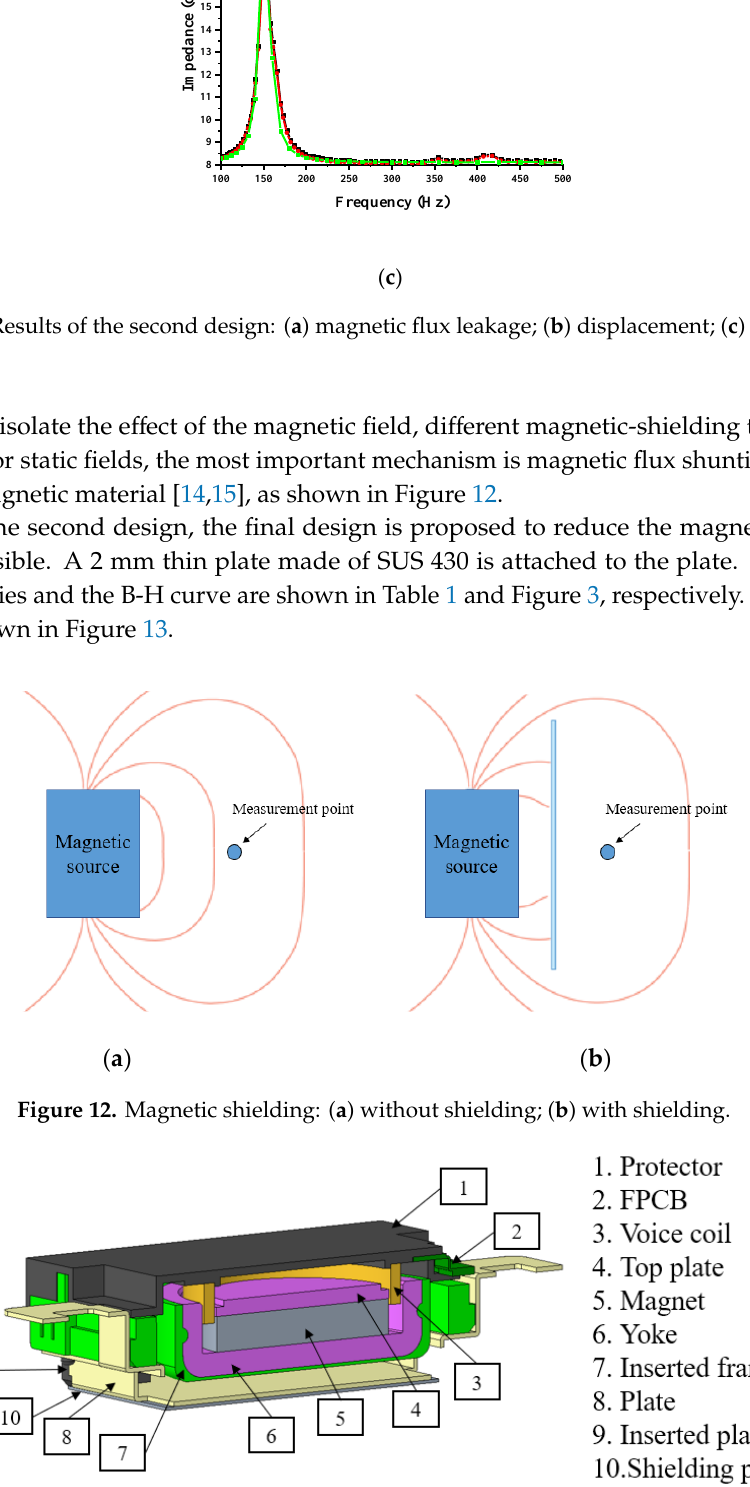
Figure 13. Final design modeling.